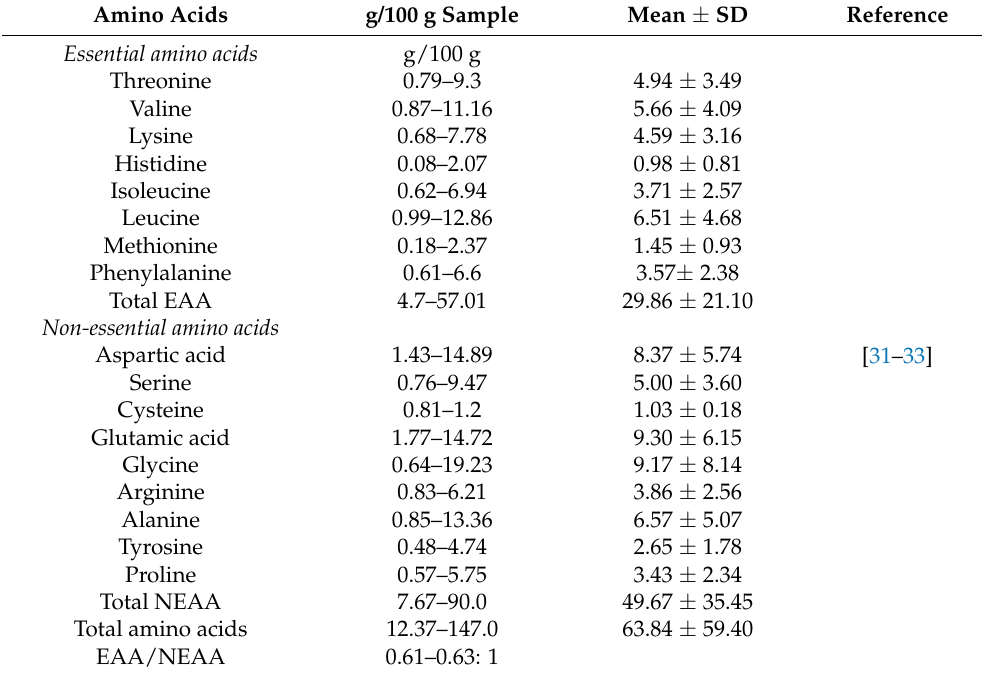
Table 3. Amino acid profile of C. lentillifera